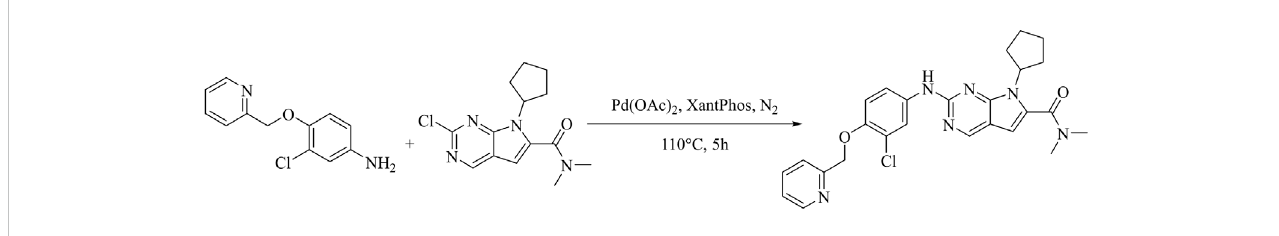
FIGURE 1 Synthetic route of compound